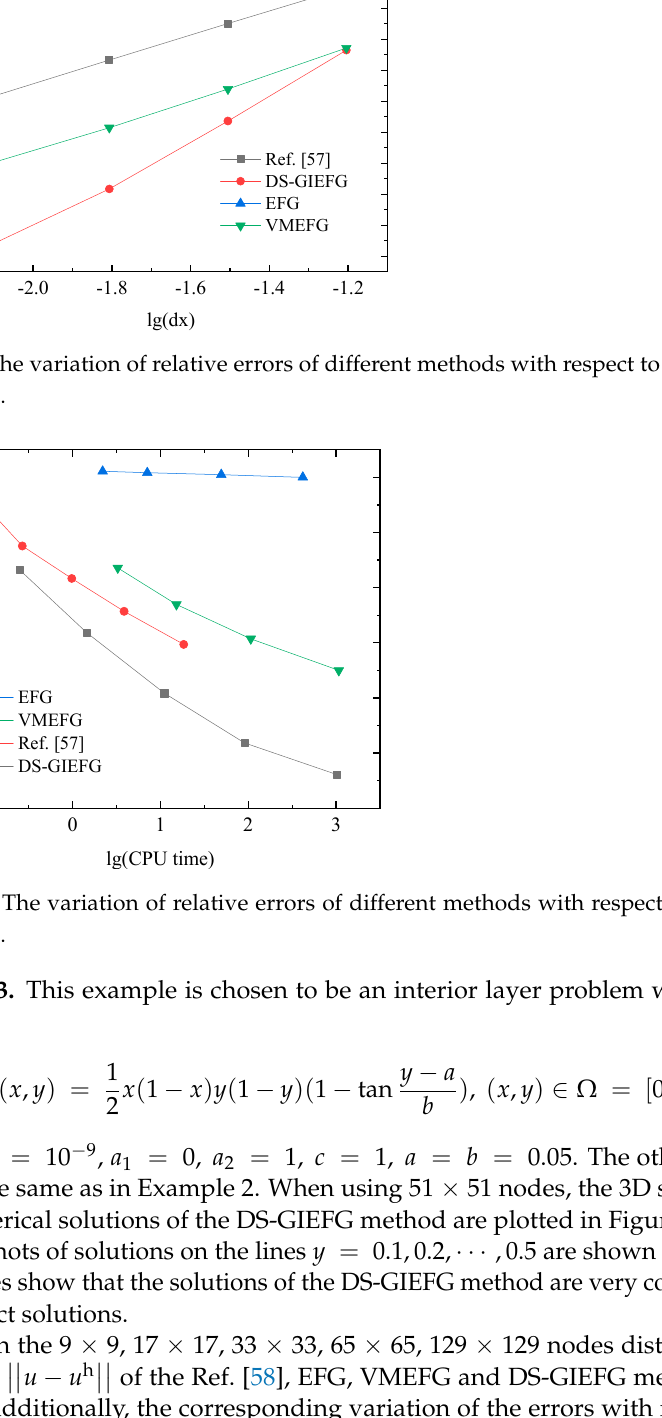
Table 1. Additionally, the corresponding variation of the errors with respect to the CPU time is shown in Figure 13. These results once again show that the method proposed